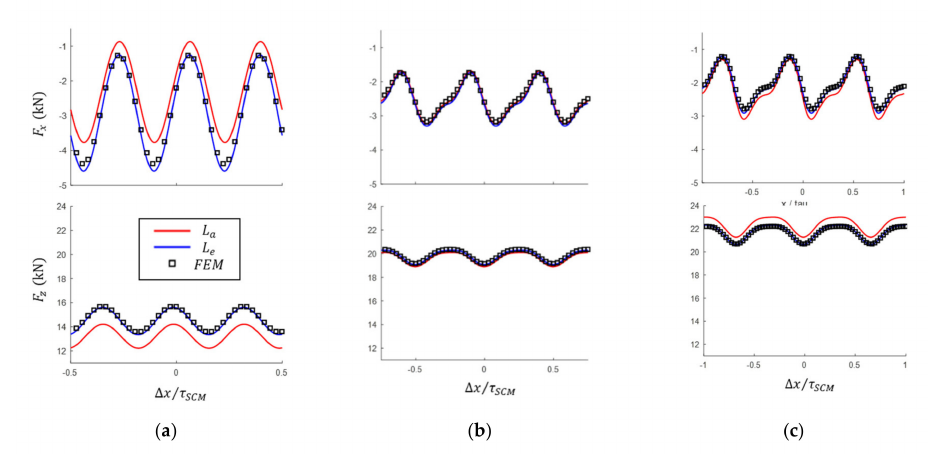
Figure 19. Drag and lift force responses acting on the SCM driving v l in the P y position from ( a ) Design A, ( b ) Design B, and ( c ) Design C.